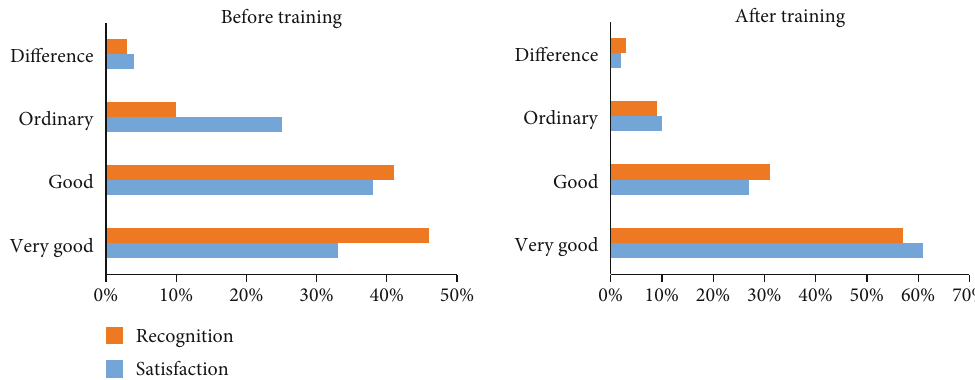
Figure 11: Survey of students ’ feelings about new media-integrated music reading training in music reading